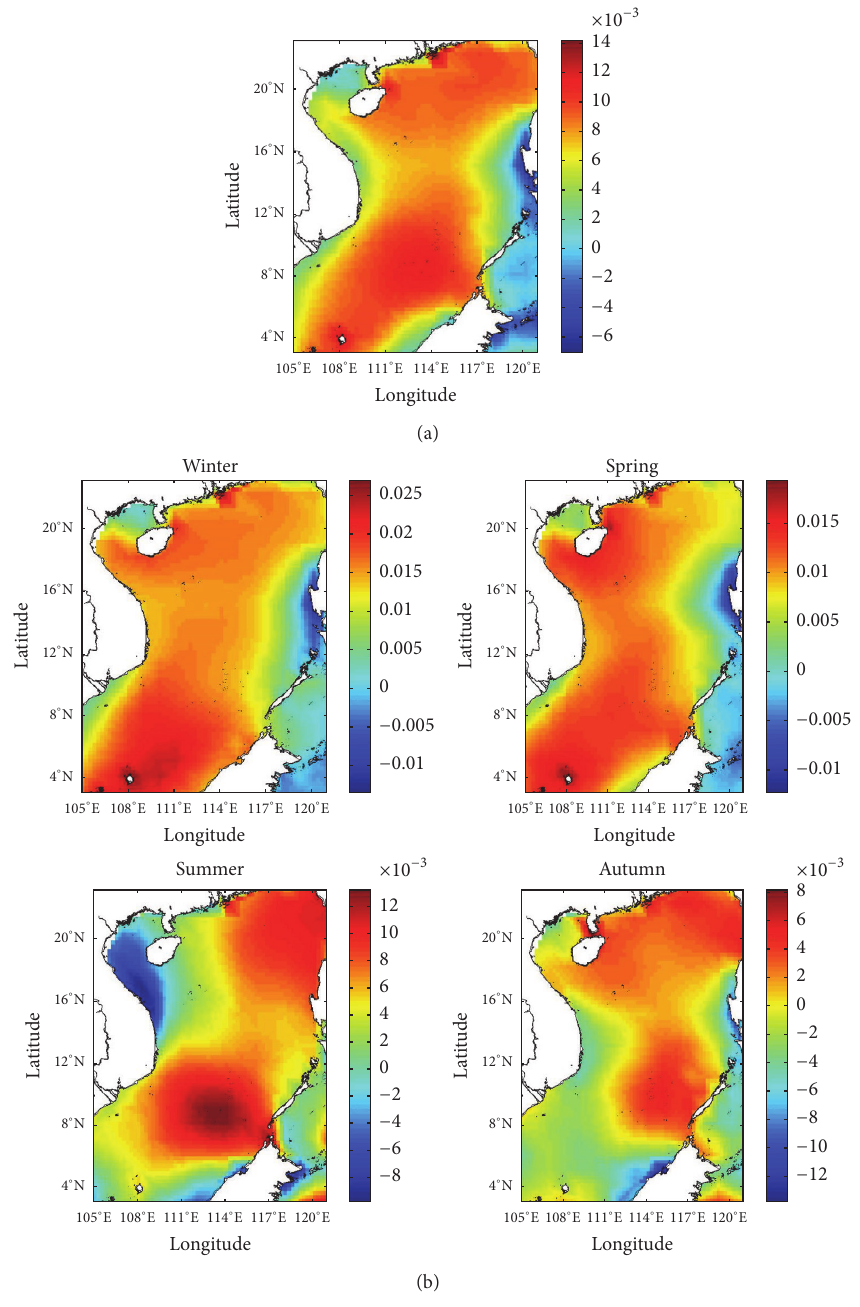
Figure 7: (a) Long-term trend of annual mean Tp from year 1976 to year 2005. Unit: syr −1 . Only trends significant at the 95% level are shown. (b) Long-term trends of seasonal mean Tp from year 1976 to year 2005. Unit: syr −1 . Only trends significant at the 95% level are shown. the least value of 5.21 s during the last 30 years. This is